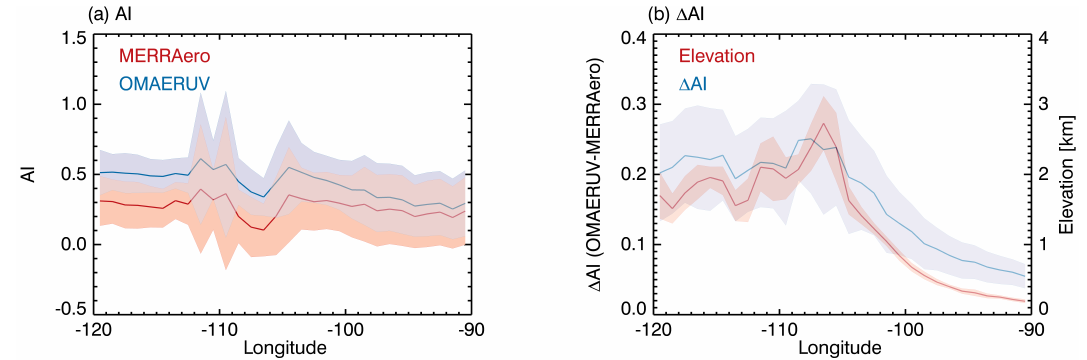
Figure 5. (a) MERRAero and OMAERUV aerosol index mean and 1 SD range for all retrievals in the box enclosing 120–90 ◦ W, 38–42 ◦ N, over the central United States during June 2007. In all, 36855 data points were considered. The OMAERUV AI shown here is computed using the MERRAero surface pressure. (b) OMAERUV–MERRAero AI residual mean difference and 1 SD about the mean over the same region (blue) and the regionally averaged topographic elevation and 1 SD about the mean